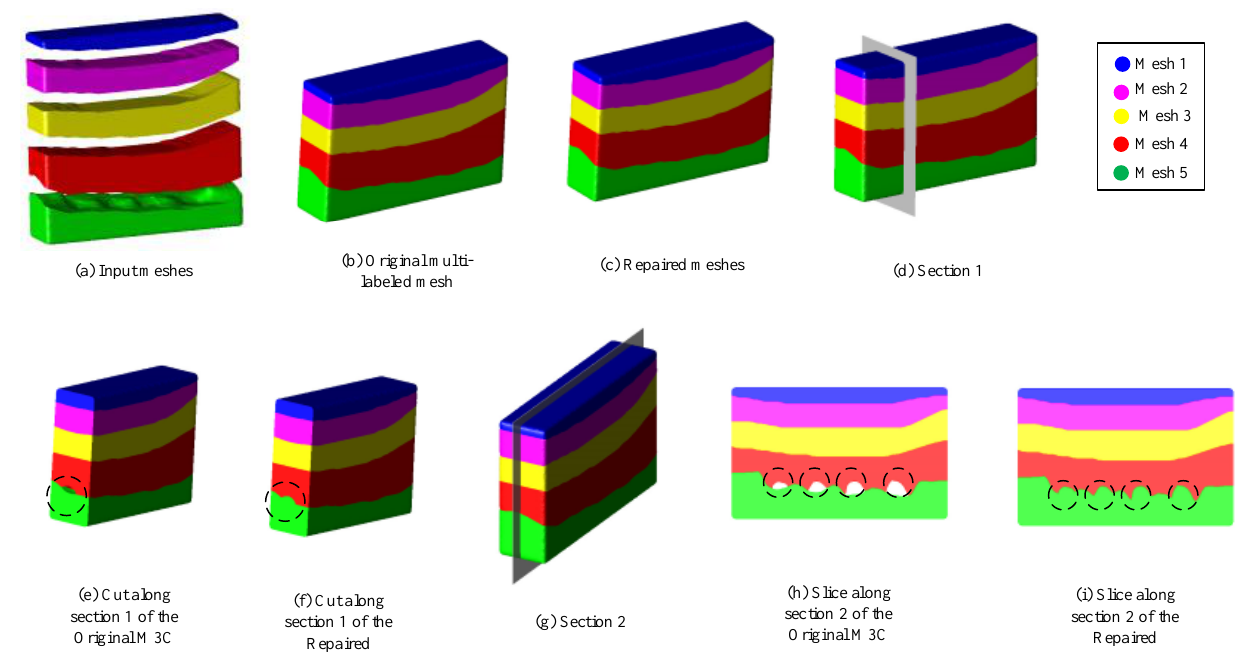
Figure 9. The multi-labeled mesh with input five sub-meshes. Table 4. Parameters of the multi-labeled mesh with input five sub-meshes. 𝑵 𝑽 is the number of voids, the Time is the time consumed in repairing the mesh, the Facets is the number of the triangular facets in multi-labeled mesh, the Vertexes is the number of mesh vertexes in multi-labeled mesh. Meshes